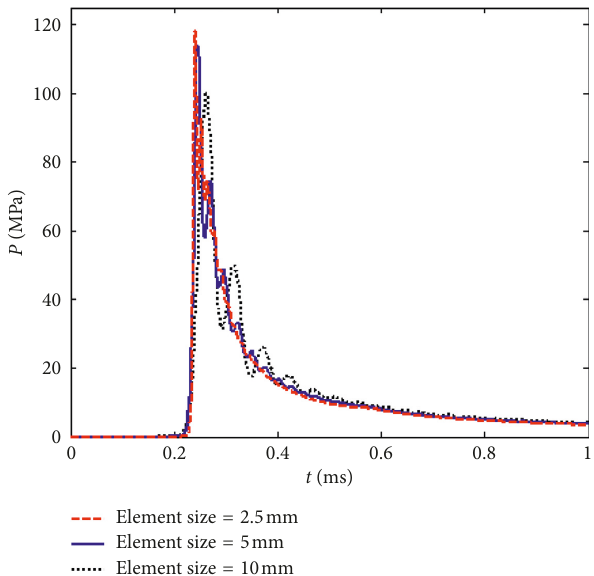
Figure 4: Shock wave pressure versus time from three different element sizes at r � 10.